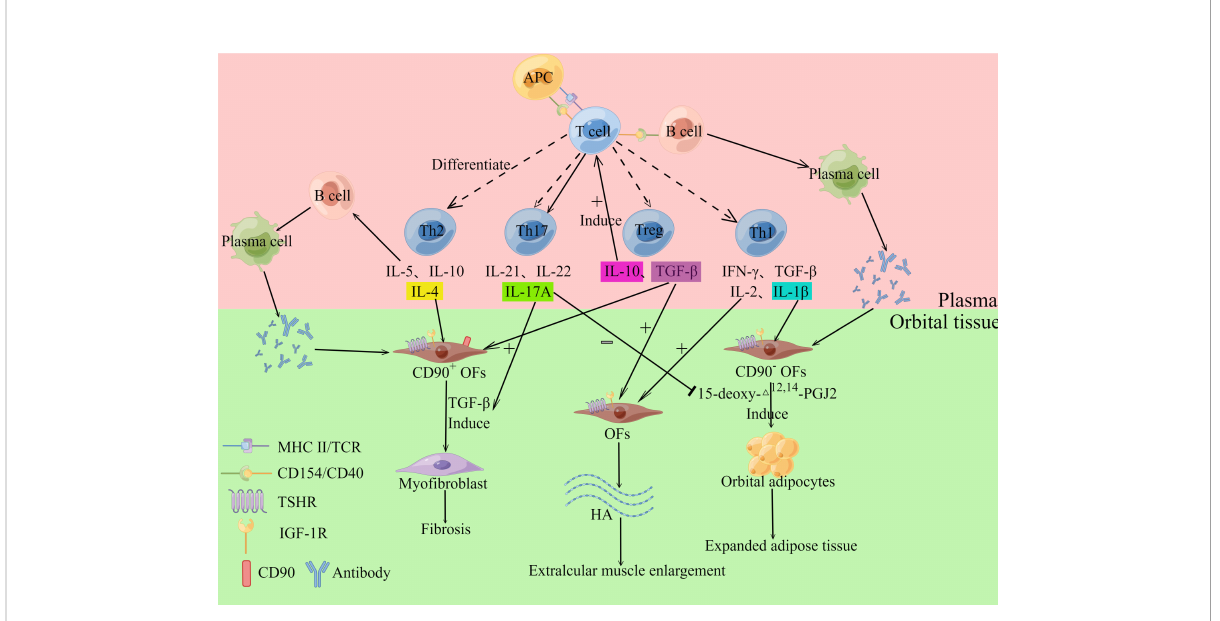
FIGURE 1 Cellular immunity. T cells can differentiate into Th1, Th2, Th17 and Treg cells, which can secrete various cytokines. Th1 cells can secrete IL-1 b , IL-2, IFN- g and TNF- a , and the above cytokines acting on Orbital fi broblasts (OFs) can induce their synthesis and release of hyaluronan (HA). IL- 1 b also stimulates OFs to differentiate into adipocytes. Th2 cells release IL-5, IL-10, and IL-4, which stimulate B cells and participate in humoral immunity. IL-4 also stimulates OFs to produce collagen, which participates in the GO fi brosis response. Th17 cells mainly secreted IL-17A, IL-21, and IL-22, among which IL-17A promoted TGF- b -induced fi brosis of CD90 + OFs while inhibiting 15-deoxy- △ 12,14 -PGJ2-induced adipogenesis of CD90 - OFs. Treg cells mainly secrete IL-10 and TGF- b . IL-10 induces T cells to differentiate into pathogenic Th17 cells. TGF- b induces OFs to produce HA and induce OFs to differentiate into myo fi broblasts. The in fl ammatory mediator (Il-1 b ) that promotes adipogenesis activates CD90 - OFs to differentiate into adipocytes. In contrast, CD90 + orbital fi broblasts were activated by TGF- b and differentiated into myo fi broblasts. By Figdraw (www. fi